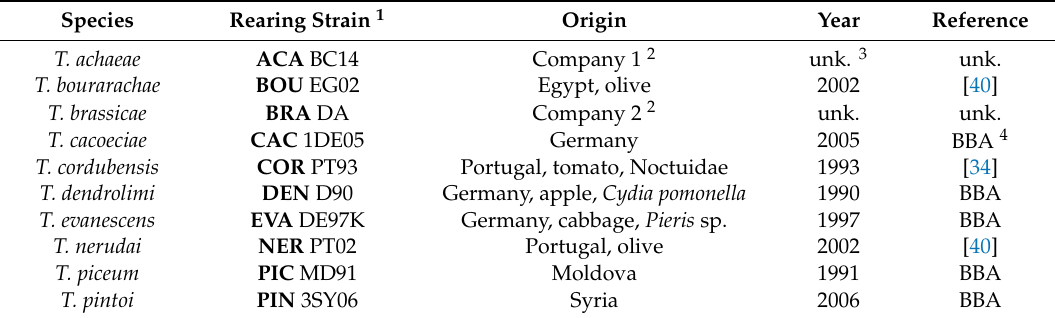
Table 1. Selected rearing strains of the genus Trichogramma and their